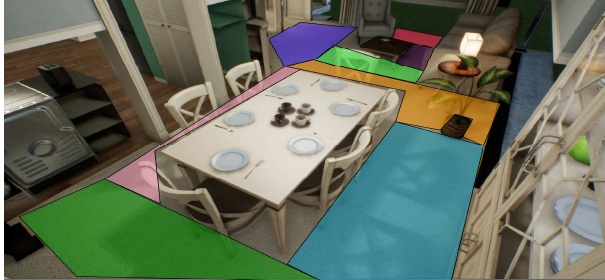
Figure 24. Environment division using navigation meshes for room